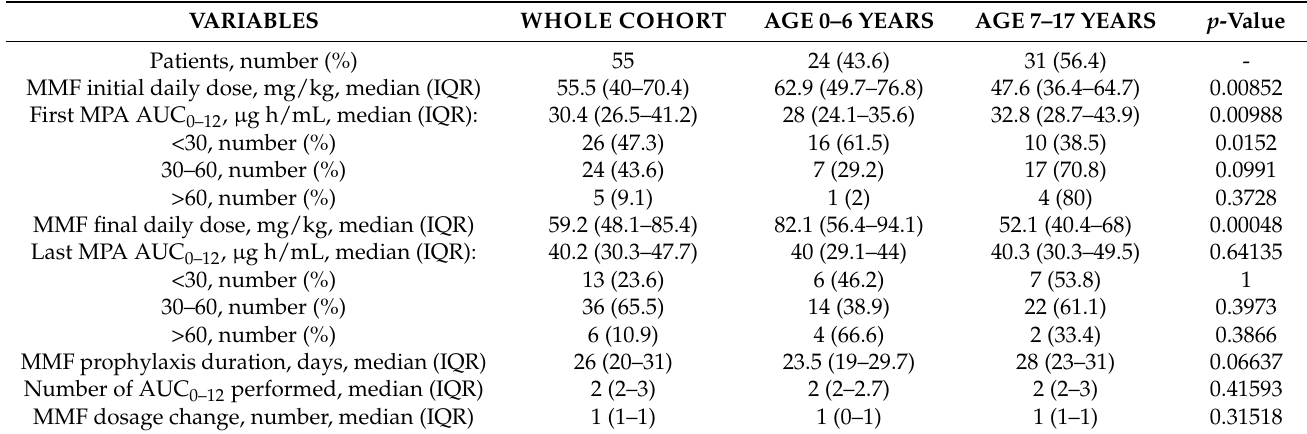
Figure 7. Box-plot analysis of secondary outcomes. Box-plot analysis showed a statistically significant difference between the initial MMF daily dose and the age at transplant, for children above and below the age of six, accounting for a reduced MMF initial daily dose for patients over six years of age ( p < 0.008) ( A ). A statistically significant difference was found in the time of myeloid engraftment between transplant recipients under or over six years of age ( p < 0.0049) ( B ). Age-related variability of MMF exposure is reported in Table 2. Table 2. Age-related variability of mycophenolate mofetil